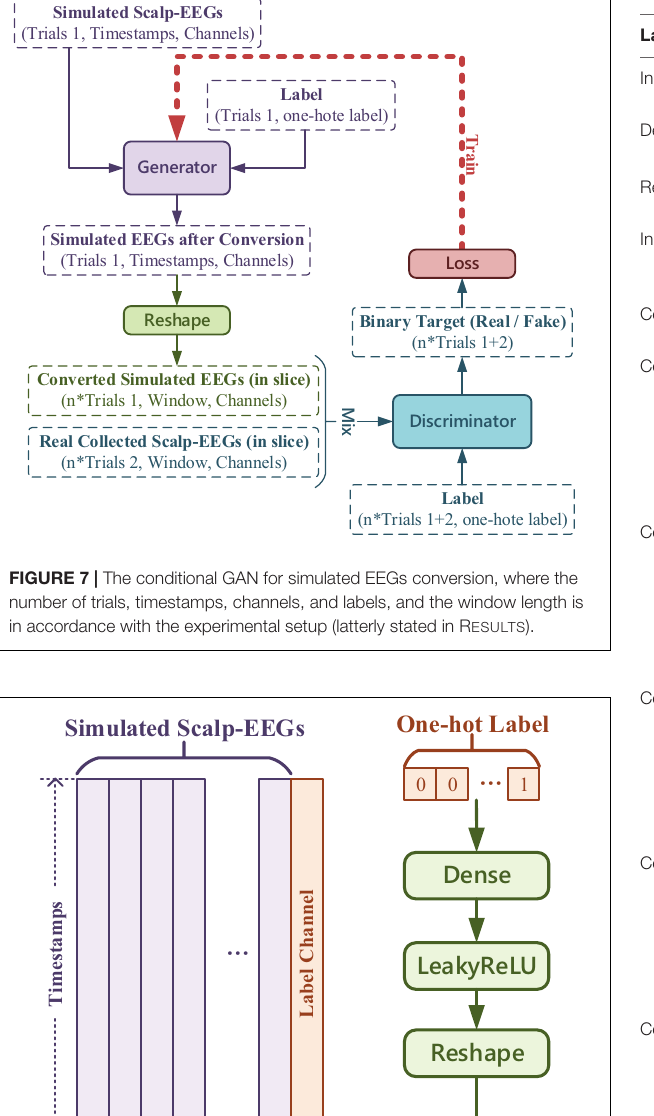
TABLE 1 | Summary of the